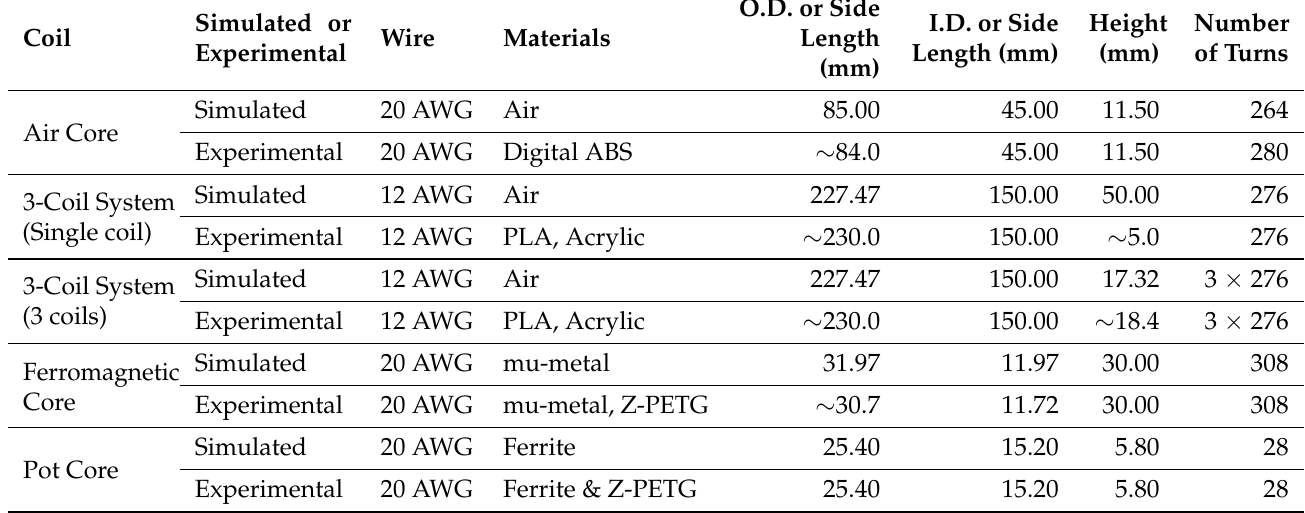
Table 1. Parameters of the simulated and experimental coils including the type of wire, materials, size, and number of turns for